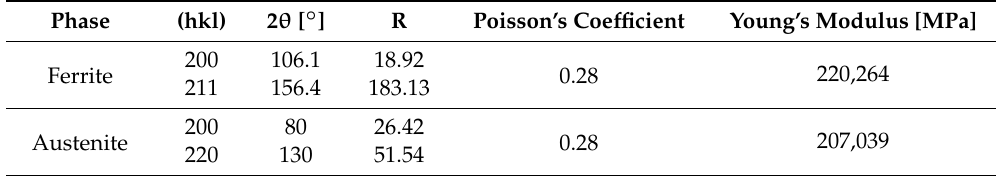
Table 3. Parameters used in the X-ray diffraction (XRD) measurements